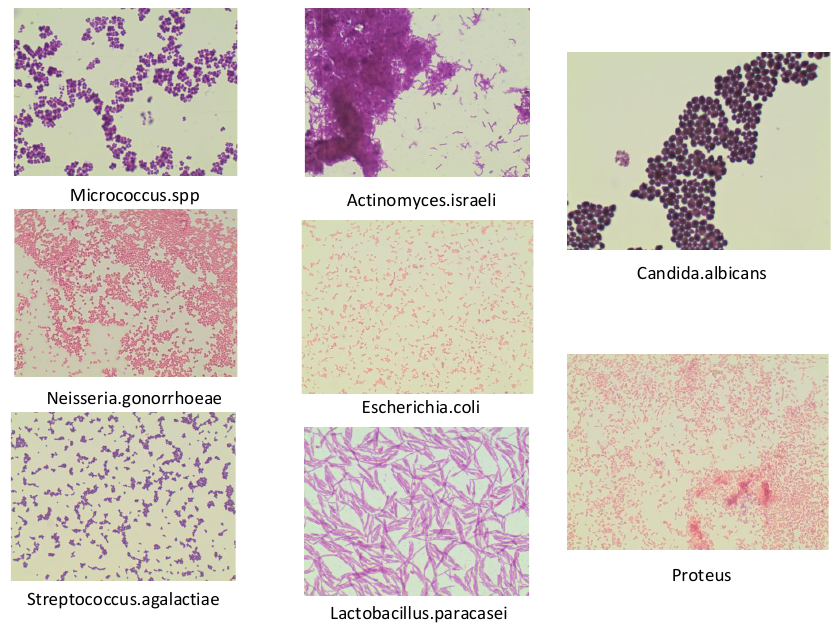
Figure 5. Bacteria samples in the DIBaS dataset